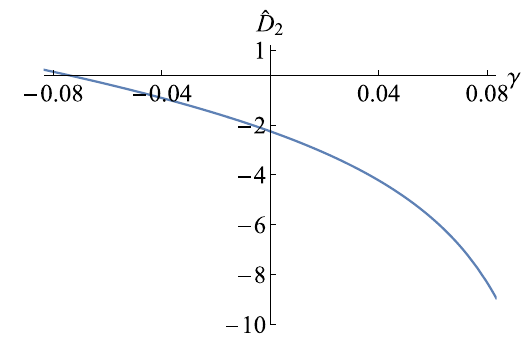
Fig. 10 ˆ D as the function of γ in the allowed region of